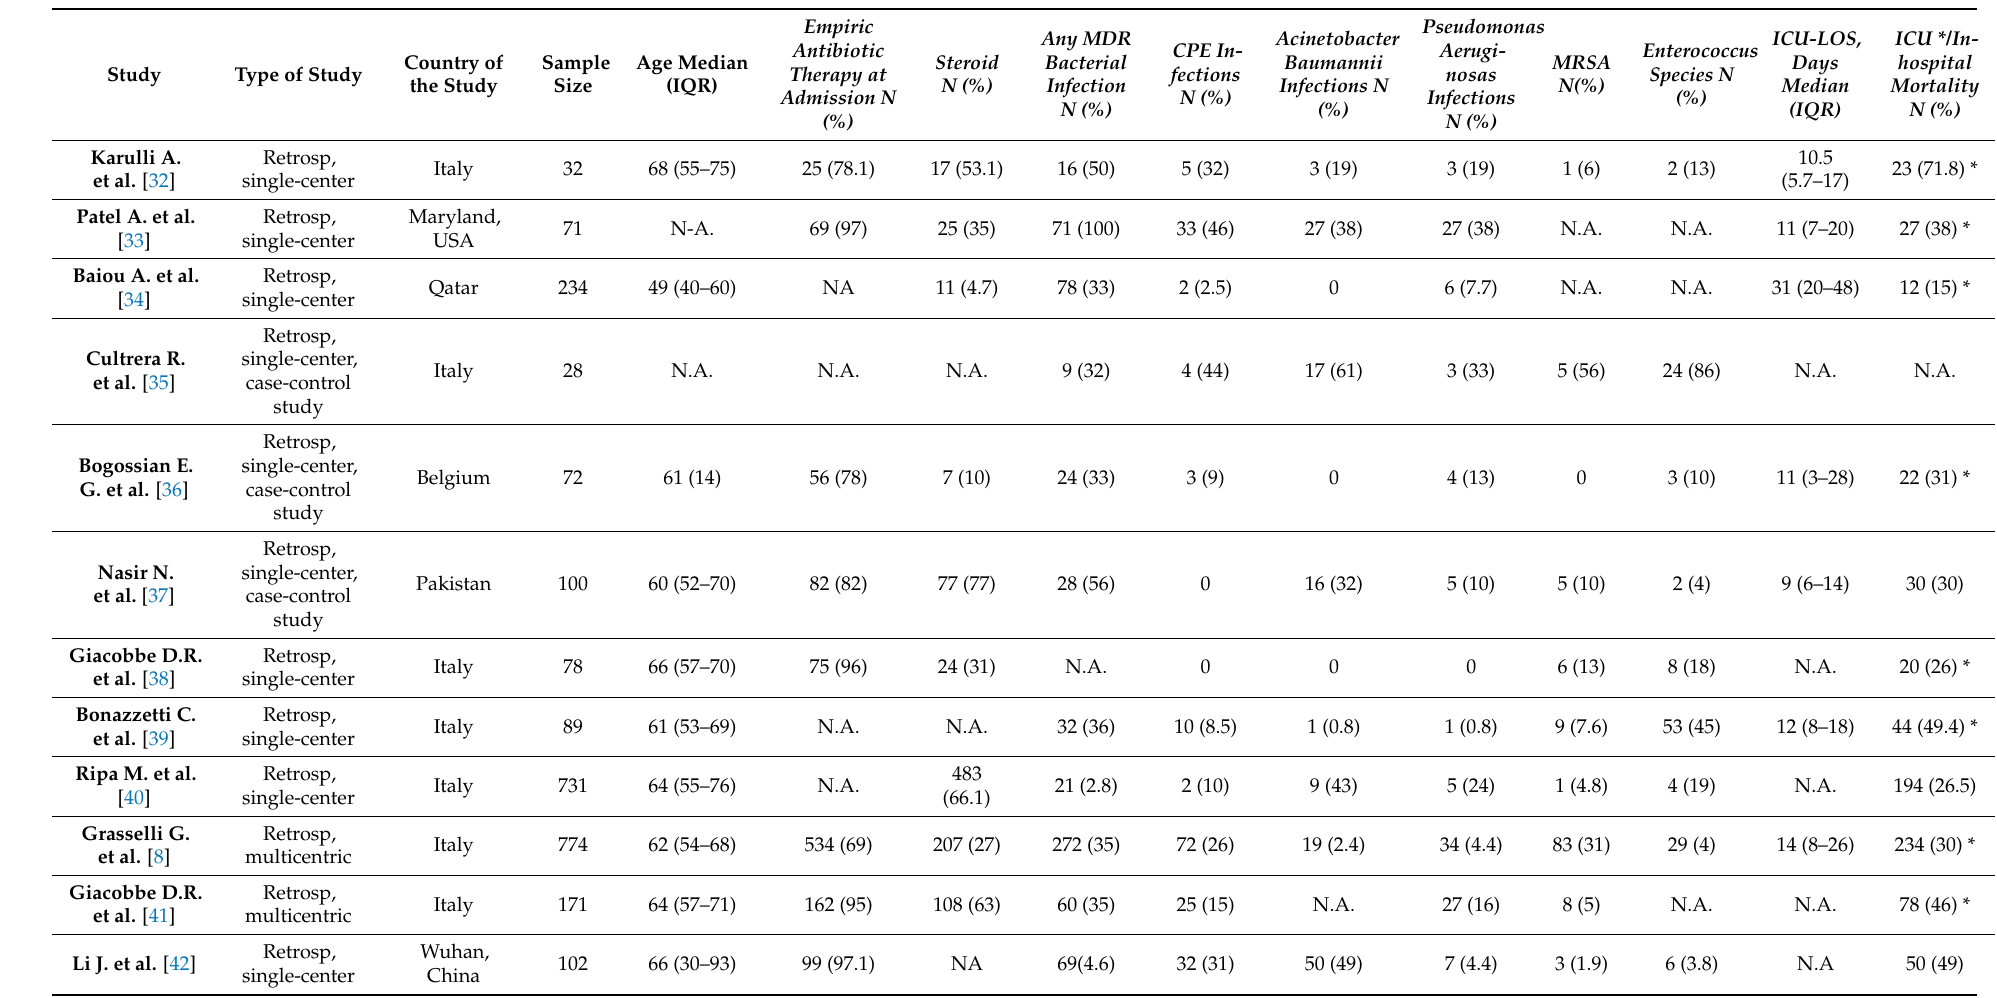
Table 1. Summary of the main studies reported data on MDR secondary infections in COVID-19 critically ill